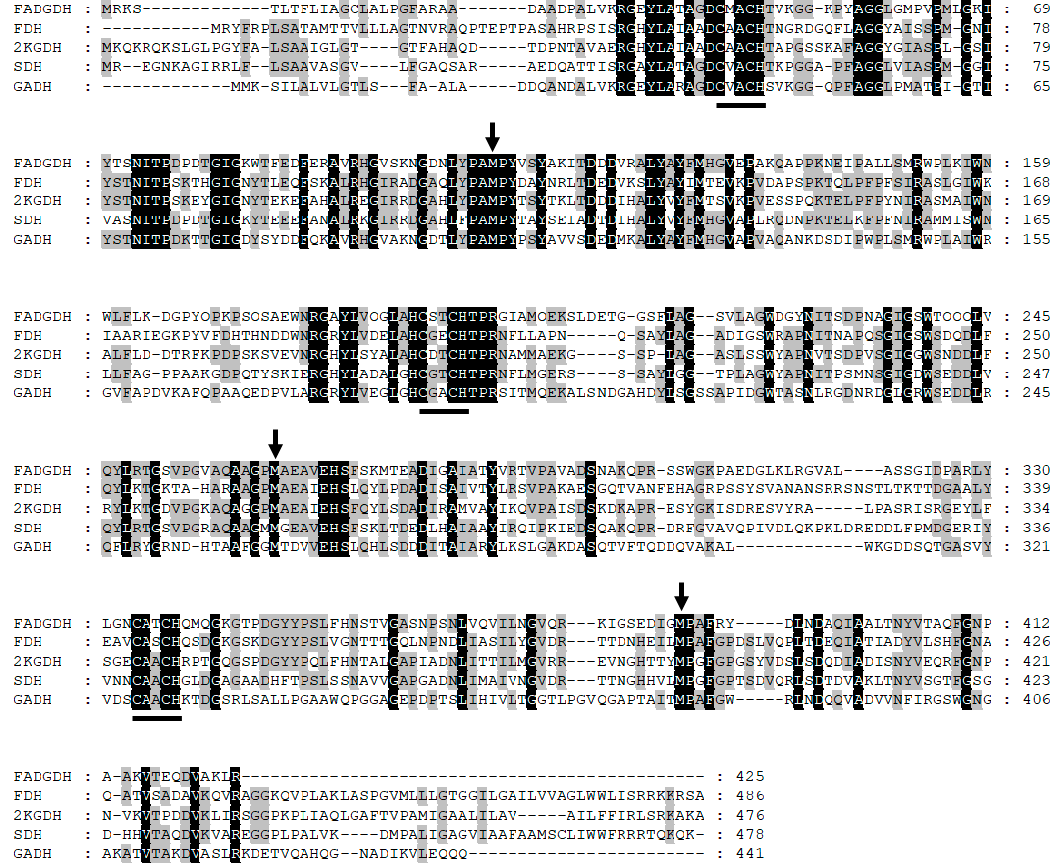
Figure 1. Primary structural alignment of the cyt c subunits of hetero-oligomeric dehydrogenases. The aligned sequences were cyt c subunits of; FADGDH: FADGDH from Burkholderia cepacia (GenBank accession no. AAQ06608), FDH: fructose dehydrogenase from Gluconobacter japonicas (GenBank accession no. BAM93251), 2KGDH: 2-ketogluconate dehydrogenase from Gluconobacter